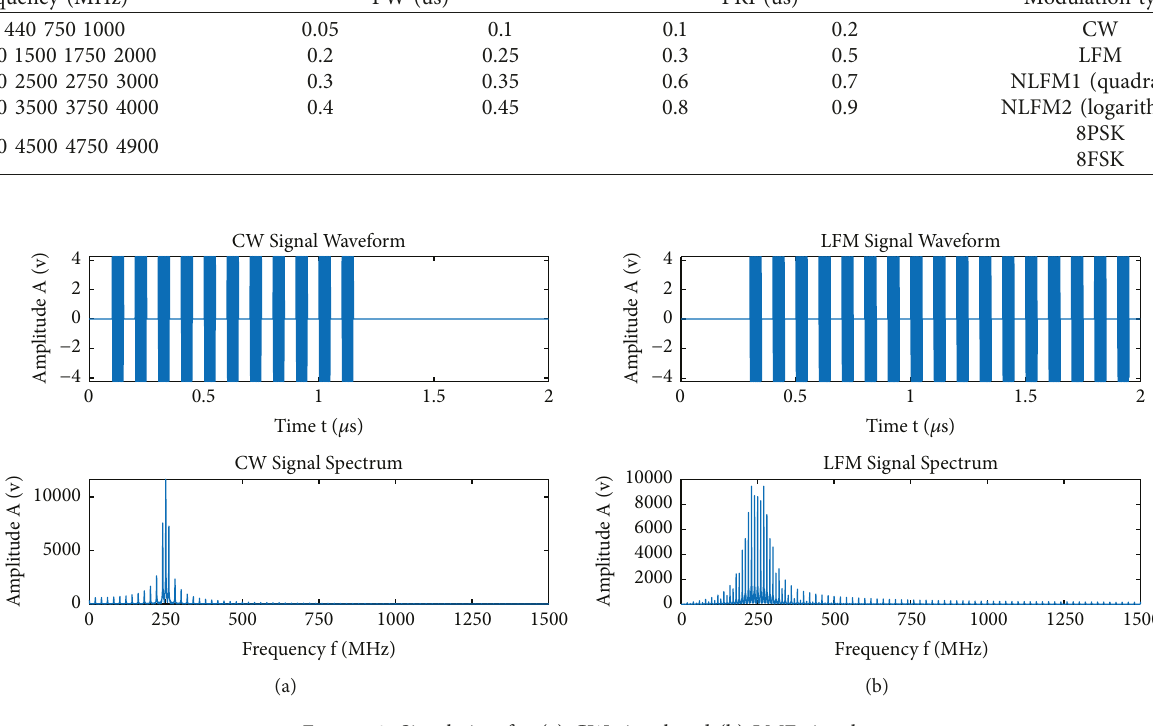
Figure 2: Simulation for (a) CW signal and (b) LMF signal.